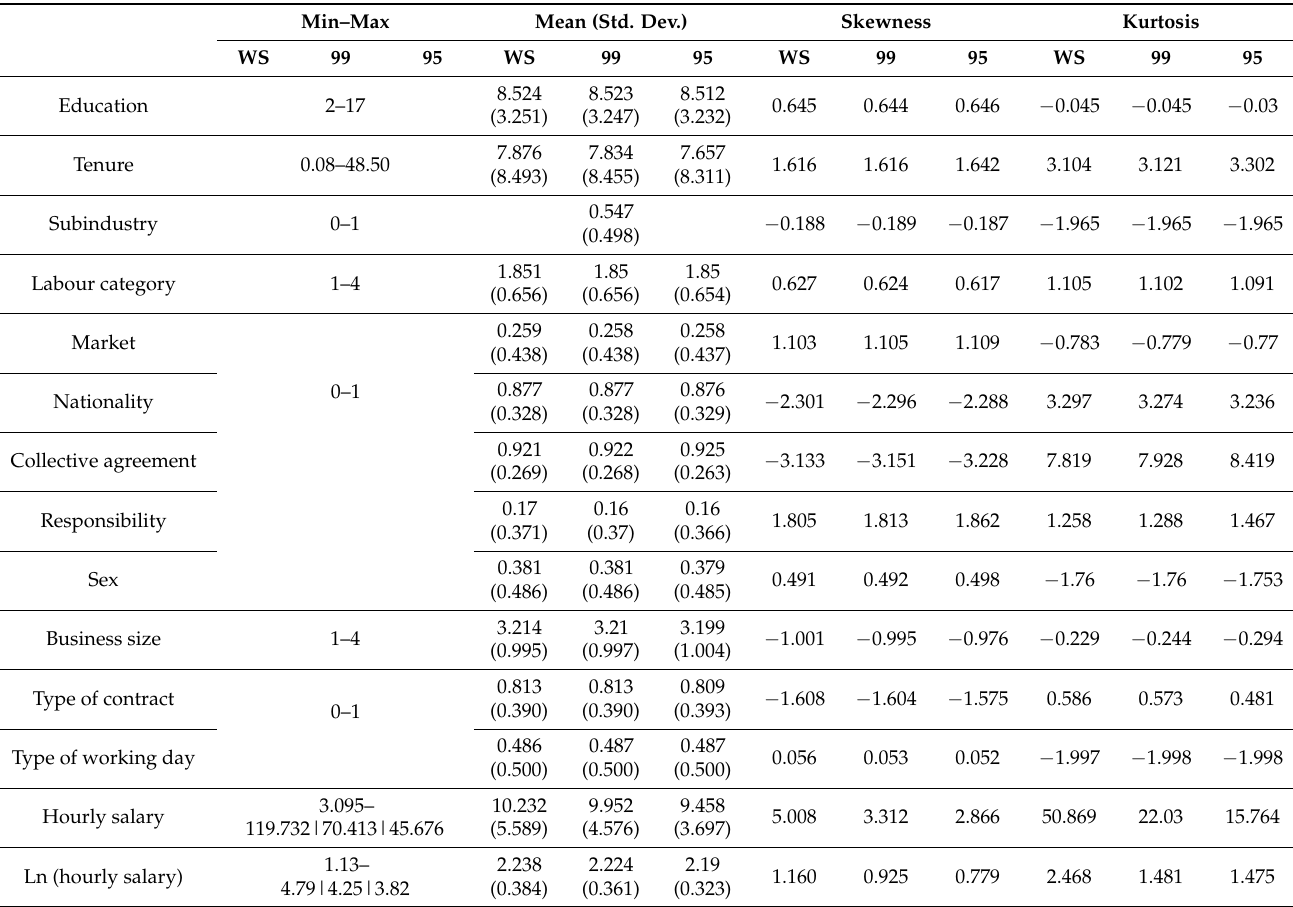
Table 1. Descriptive statistics of the studied